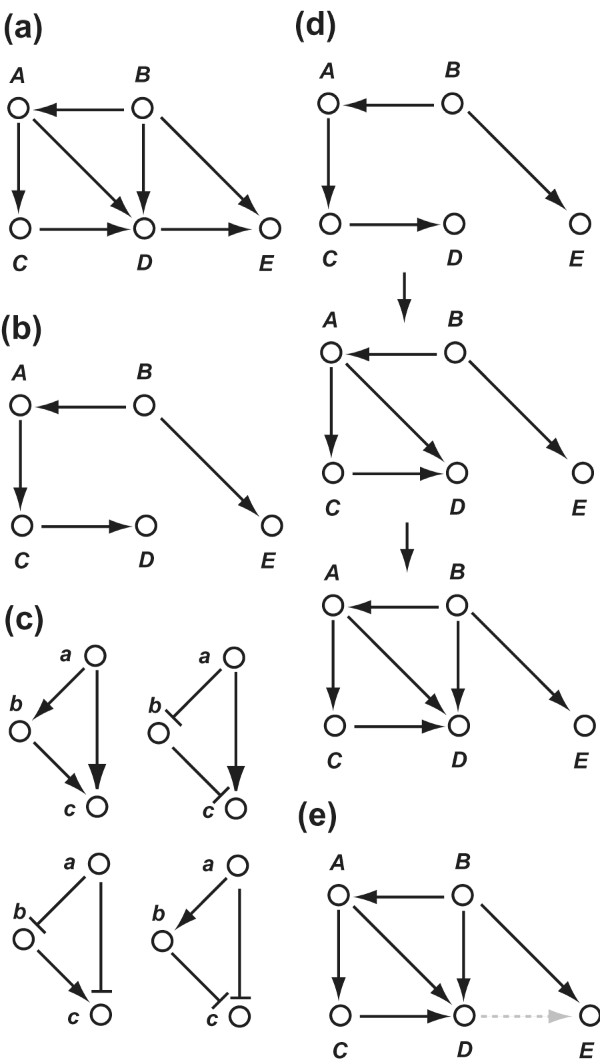
Introduction to the function "exp" and the concept "cover". (a) Initially deduced edges (Eide). (b) A set of edges (Ep). (c) Four cases of exp(a, b, c) = 1. In each case, (a, c) is explained by (a, b) and (b, c). (d) The set of edges that are covered by edges in Ep (). (A, C) and (C, D) explain (A, D); the (A, D) and (B, A) explain (B, D). Thus, (A, D) and (B, D) are covered by edges in Ep. (D, E) is not covered by edges in Ep because (D, E) cannot be explained by edges in Ep. (e) Edges that are covered by edges in Ep (black) and those that are not covered by edges in Ep (gray-dotted).